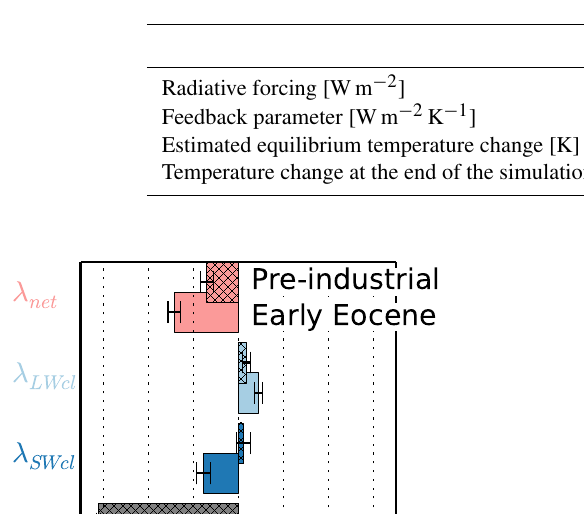
Table 4. Net radiative forcing by afforesting a dark desert world for the early Eocene climate and for pre-industrial conditions. Further, the net feedback parameter and the equilibrium temperature change are listed. The values are derived from the comparison of the respective forest world with the respective dark desert world using the linear regression approach (Sect. 3.1). The estimated equilibrium temperature change is based on Eq. (6). The 95% confidence interval is given. The temperature change at the end on the simulations considers the average over the last 30 years of the simulation.